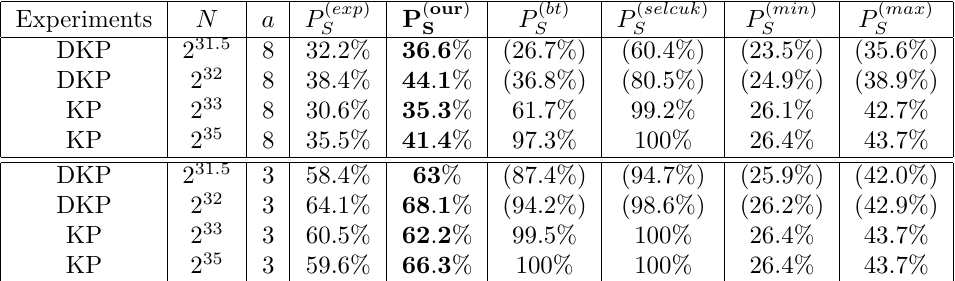
Table 5: Results of our experimental linear attacks on 20 rounds SIMON32/64. The different notations are defined in Appendix B.1. Values in brackets have been computed assuming that N DKP = N KP since the corresponding models do not make distinction between DKP and KP sampling, that is, the estimates of the success probability are derived using binomial